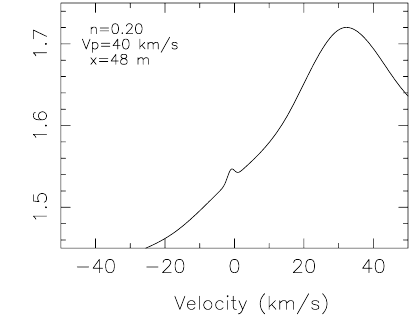
Fig. 10. The function F